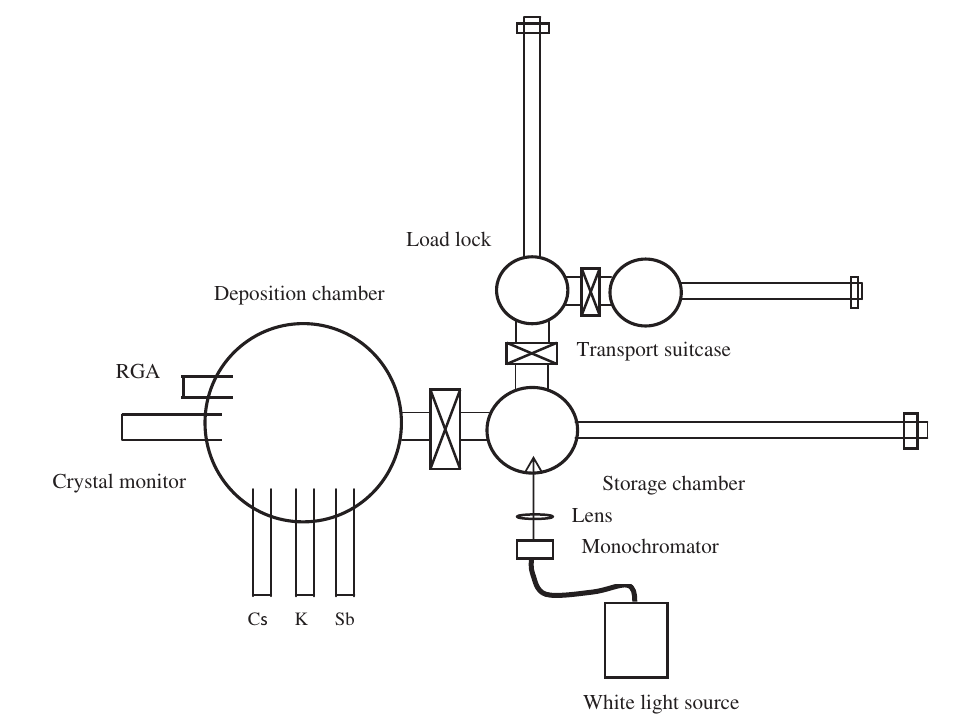
FIG. 1. A schematic of the BNL ’ s K 2 CsSb photocathode deposition